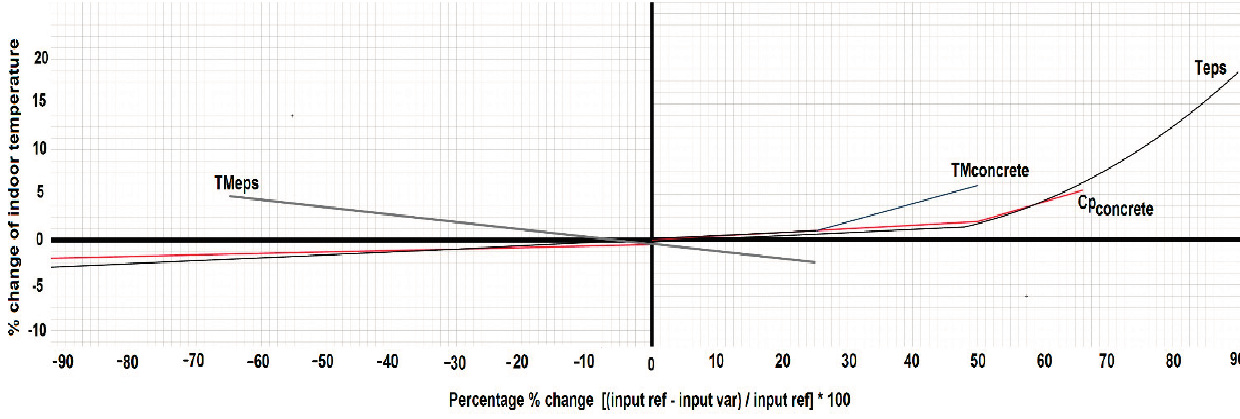
Figure 8. Effect of the building envelope parameters in the indoor